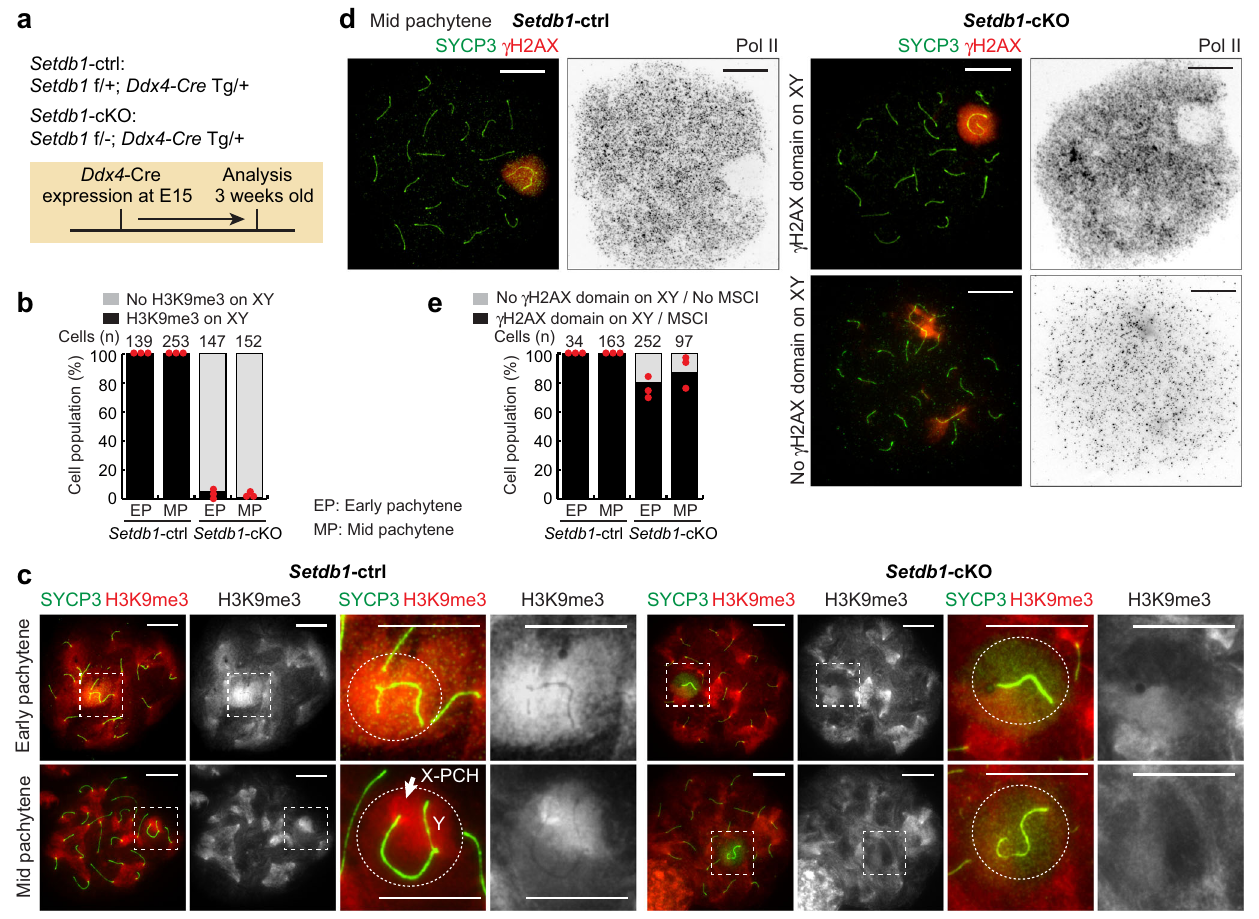
Fig. 7 | SETDB1-dependent H3K9me3 is dispensable for the initiation of MSCI. a Schematic of the strategy for generating Setdb1 -cKO mice. b Evaluation of the ef fi ciency of SETDB1 deletion shown as the mean and individual values for 3 independent samples. c Chromosome spreads of early and mid pachytene sper- matocytes, distinguished by the absence (early) or the presence (mid) of H1T, respectively(notshown),immunostainedwithantibodiesraisedagainstSYCP3and H3K9me3. XY chromosomes are indicated with dashed squares and are magni fi ed inthepanelstotheright.PutativeregionsofXYchromatinareindicatedbydashed